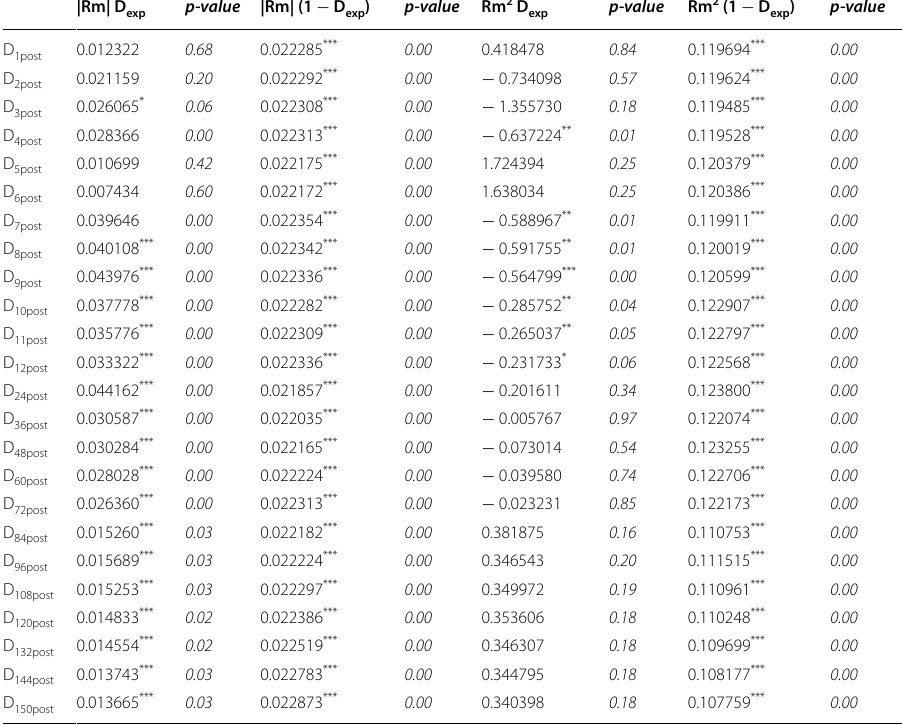
Table 4 Conditional hourly herding around the expiration. Effects after